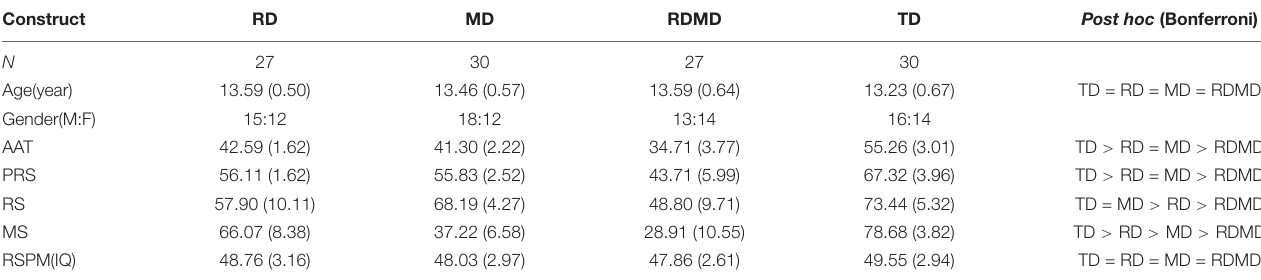
TABLE 1 | Means and standard deviations and demographic characteristics and group effects for test scores for the four groups.